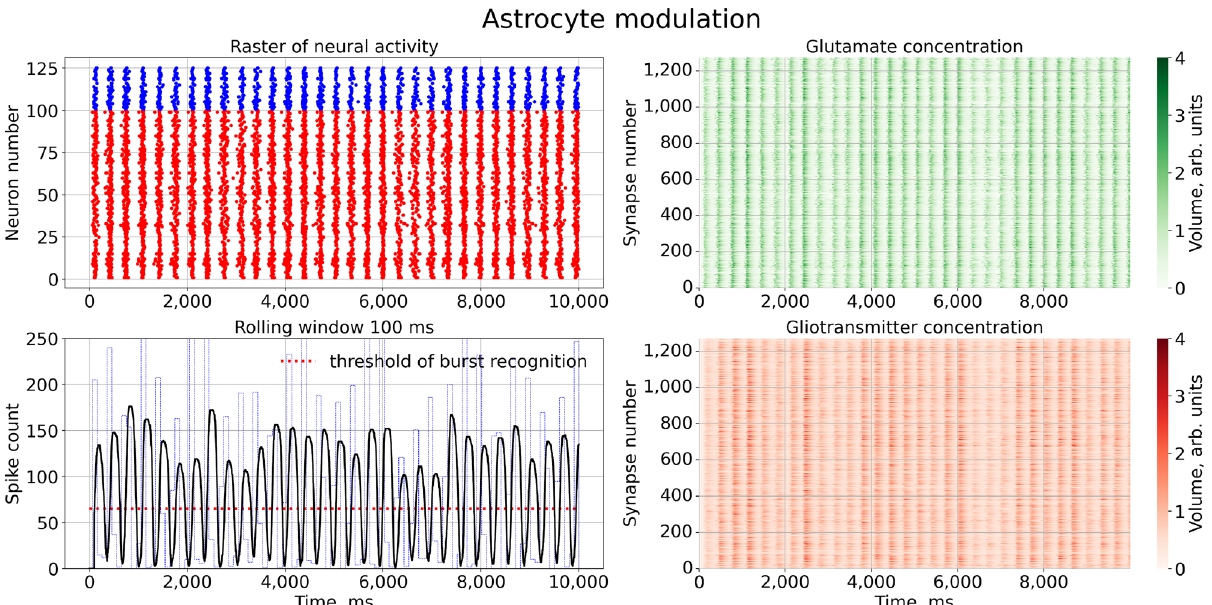
Figure 3. Network firing under normal conditions. Left upper panel: A raster plot of neural activity, with red dots indicating spikes by excitatory (glutamatergic) piramidal neurons and blue dots indicating spikes by inhibitory (GABAergic) interneurons. Right panels: Changes in the extracellular concentrations of synaptic glutamate diffused from the cleft (green color) and the glutamate released by astrocyte (red color) for all tripartite synapse. Left lower panel: the count of spikes over a sliding time window of 100 ms is shown for the entire simulation time of the model. We set the burst generation threshold at 65 spikes, marked by a red dashed line. The parameter values used are: for neuron - a = 0.02, b = 0.5, c = − 40, d = 100, k = 0.5, C = 50, V r = − 60, V peak = 35, V 0 = − 60, U 0 = 50 ; other - τ y = 4, τ X = 100, α Y = 80, β Y = 1, X thr = 5.6, γ Y = 0.72